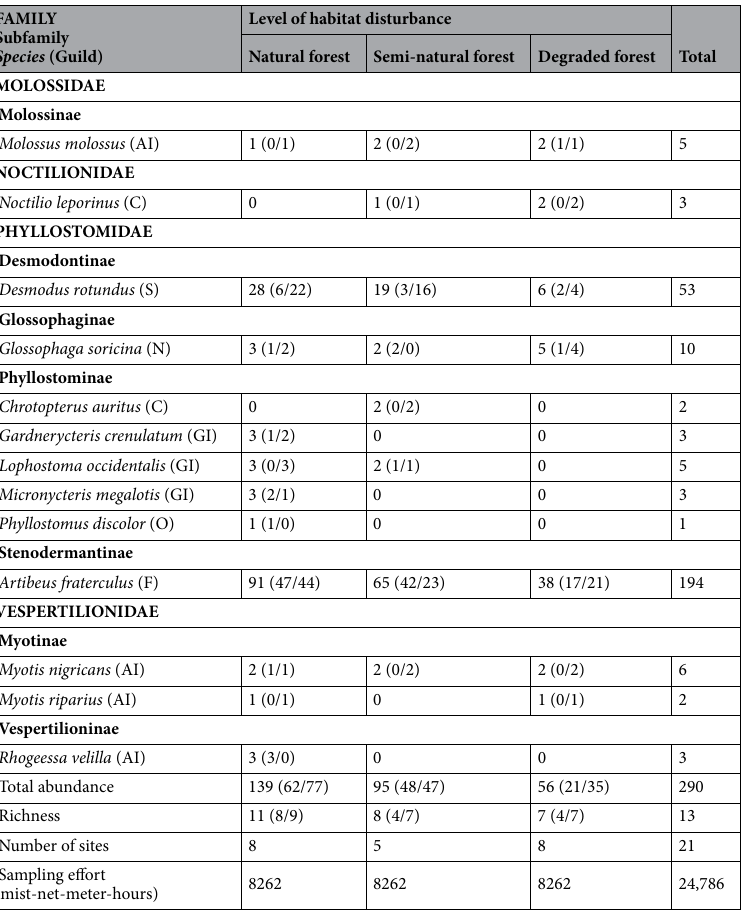
Table 1. Total number of bats captured in three levels of habitat disturbance (numbers outside parentheses) and in forest and riparian habitat nested within each disturbance level (numbers within parentheses corresponding to forest/riparian). Species guild assignations are based on Brito et al. 33 and Tirira 34 : aerial insectivore (AI), carnivore (C), frugivore (F), gleaning insectivore (GI), nectarivore (N), omnivore (O) and sanguivore